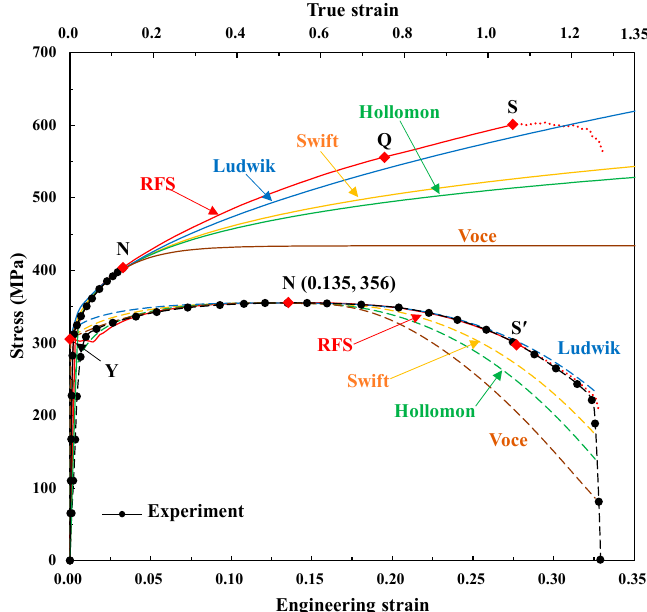
Figure 12. Comparison of flow stresses and their corresponding tensile test predictions of the four fundamental flow models with an emphasis on necking point and yield strength.